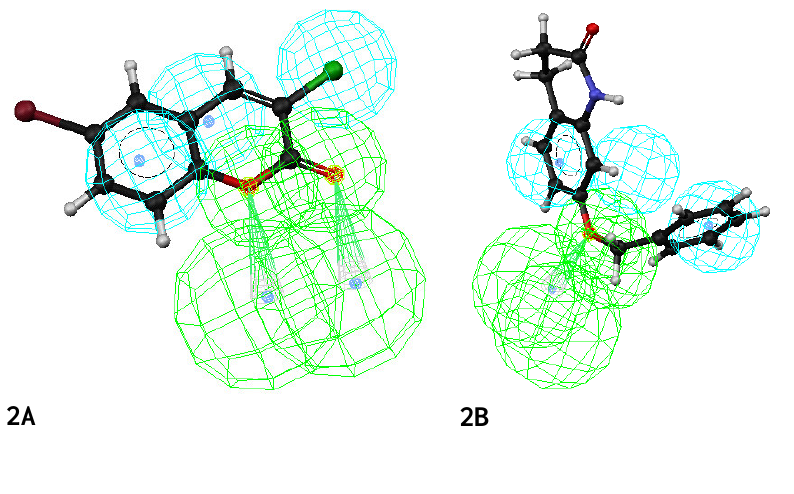
Figure 2: A) Active molecule 64 in training set B) Low active molecule 26 in the training test